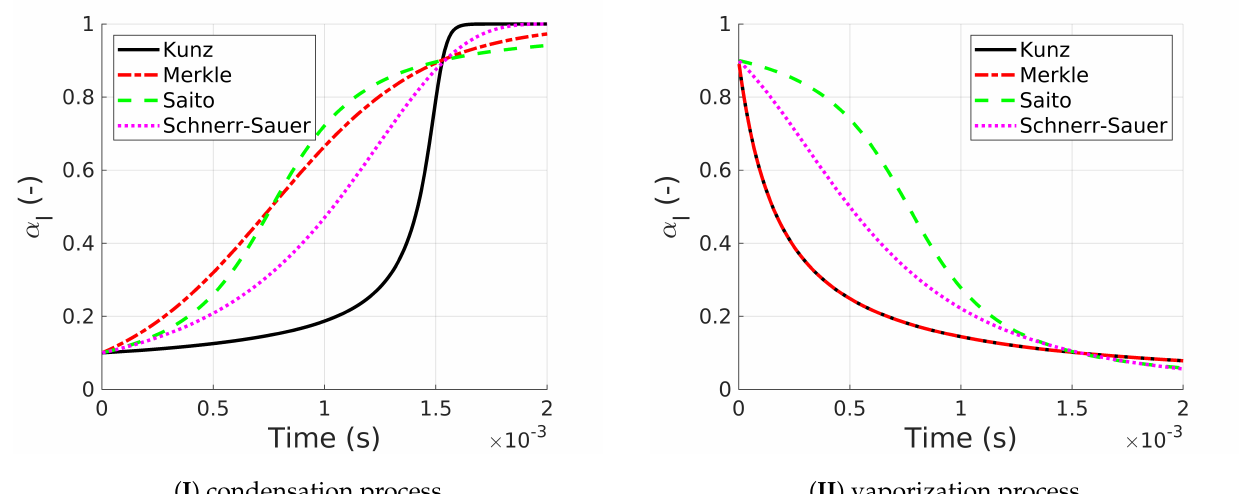
Figure 2. Condensation and vaporization processes with analytical-based